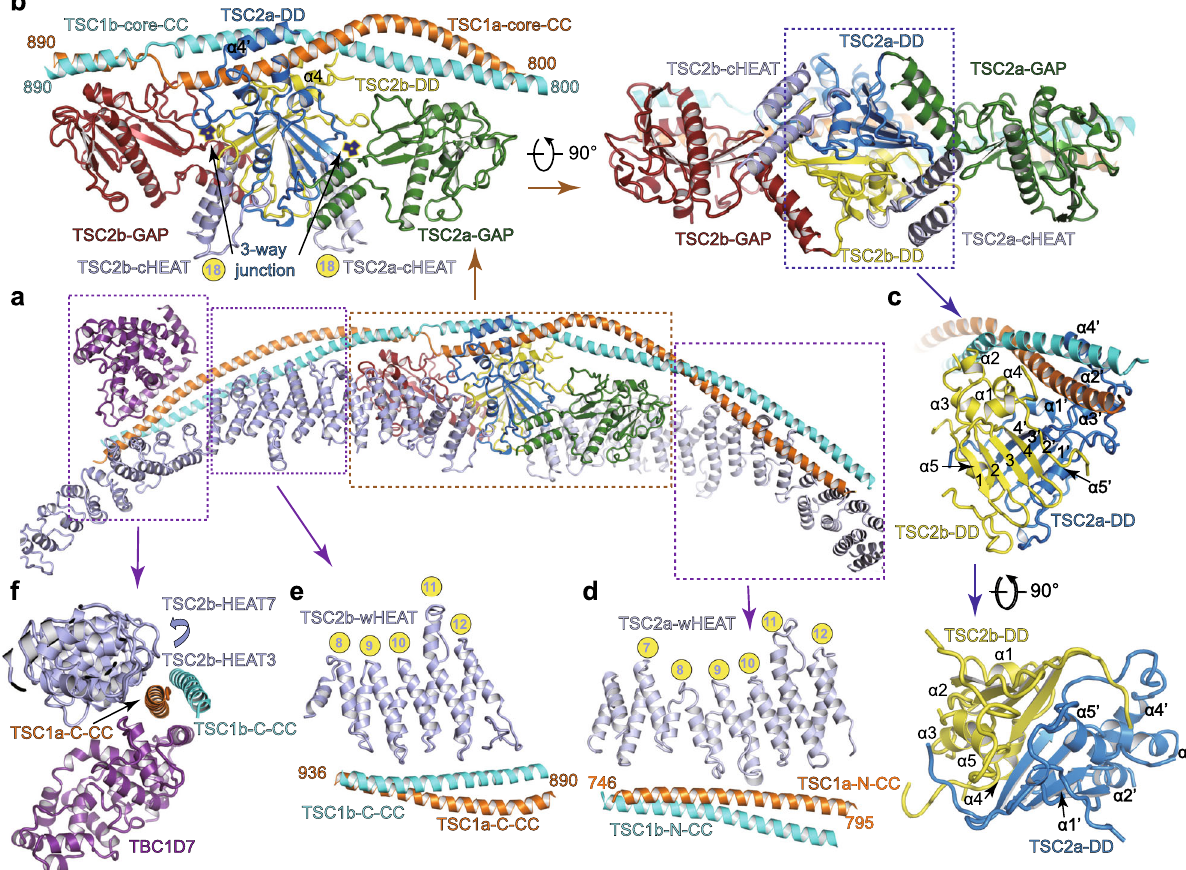
Fig. 2 Intermolecular interfaces of TSC complex. a Overall structure of TSC complex shown in a view different from that in Fig. 1b, intermolecular contacts shown in ( b – f ) are highlighted with dashed boxes. b Close-up view of the intermodular interactions in the central core module. Close-up view of the intermodular interactions in the dimerization domain ( c ), wing-a ( d ), wing-b ( e ), and TSC1 C-CC with TBC1D7 ( f ). Critical elements are indicated. In ( c ), α 1 – α 5 and α 1 ′ – α 5 ′ represent α helices of TSC2b and TSC2a, respectively. The numbers (1 – 4 and 1 ′ – 4 ′ ) represent the numbered β